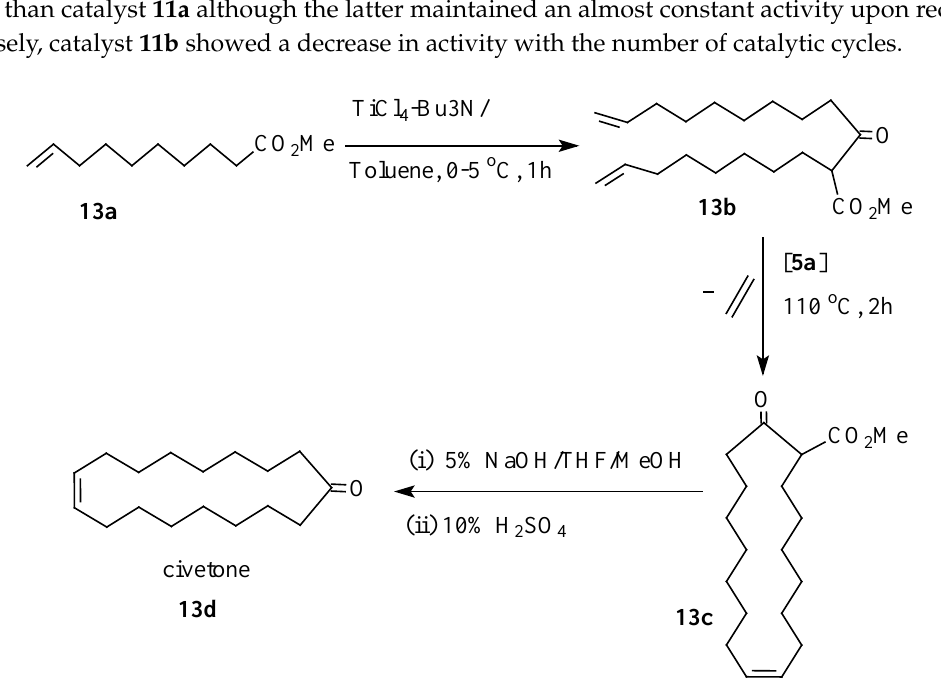
Scheme 7. RCM of dimethyl diallylmalonate in [bmim][NTf2].